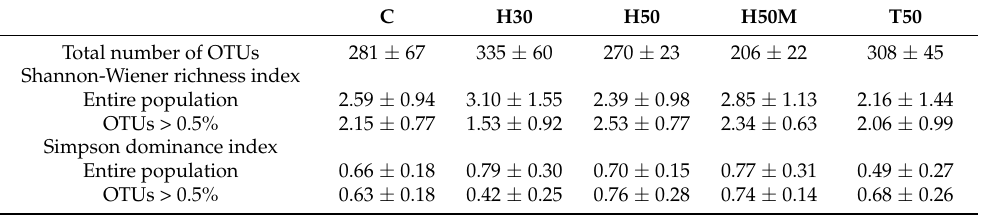
Figure 2. Digestive enzymes of Sparus aurata fed with experimental diets. Means ( ± SE) of three replicate tanks (30 fish/tank). Different letters indicate significant differences ( p < 0.05) based on Tukey–Kramer HSD tests. Table 6. Number of OTUs and values for some α biodiversity indices observed for different treat- ments. Biodiversity indices are shown for the entire community, as well as for the community comprising those OTUs representing 0.5% of the relative abundance in at least one of the samples.